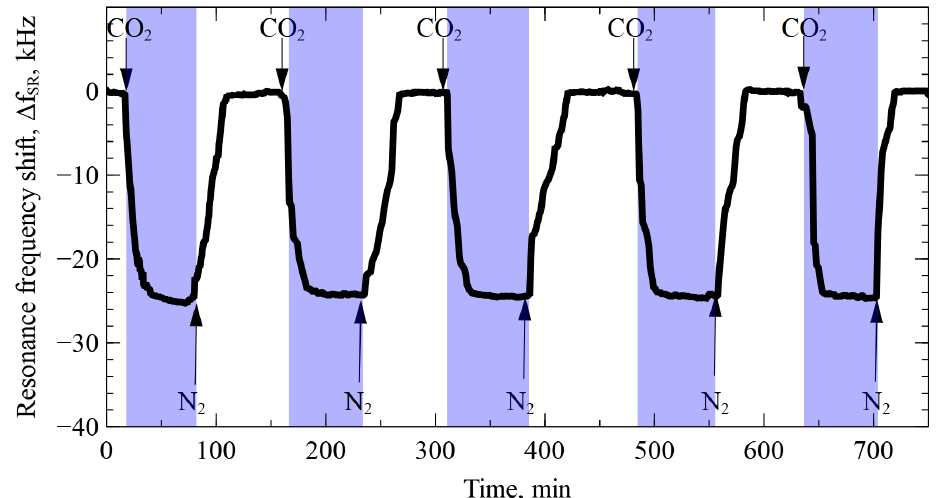
Figure 10. Transient plot of the sensor readings in response to the CO 2